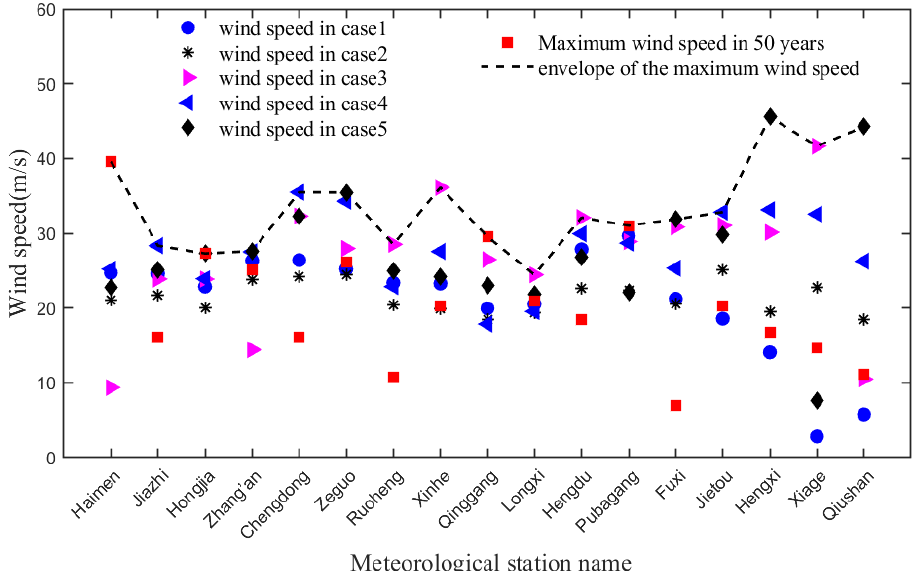
Figure 8. Maximum wind speed results and their envelope for the 17 meteorological stations in Taizhou City. Table 8. Comparison of the simulated and reference wind speeds at the 17 meteorological stations in Taizhou City.